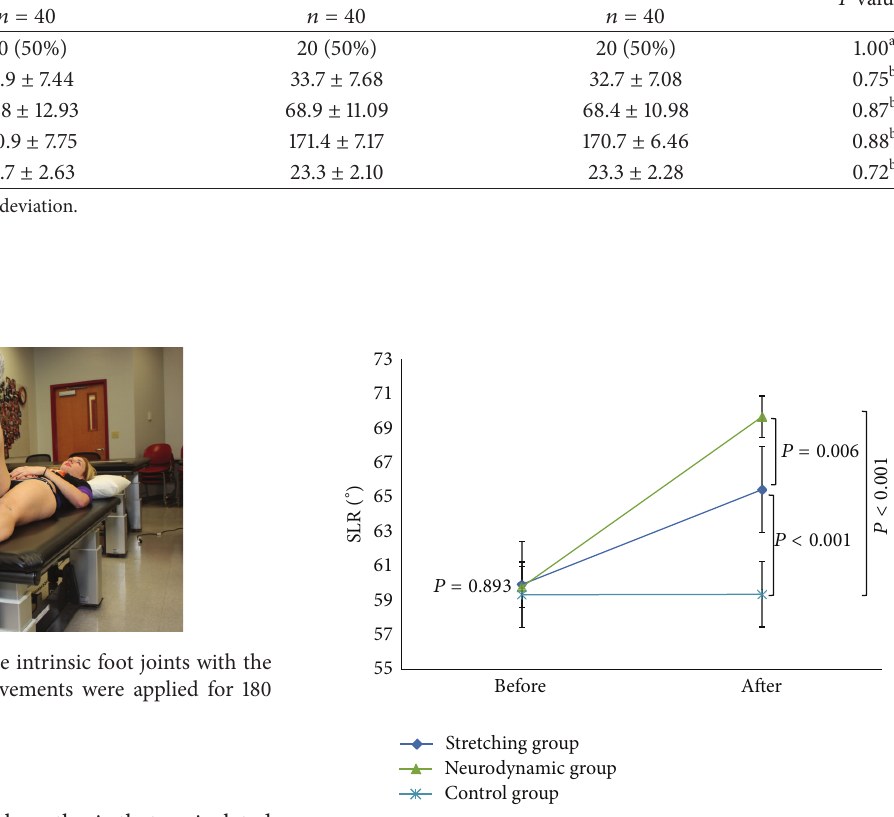
Figure 6: Before and after mean straight leg raise (SLR) values ( ∘ ) with 95% confidence intervals of hamstring extensibility among the three